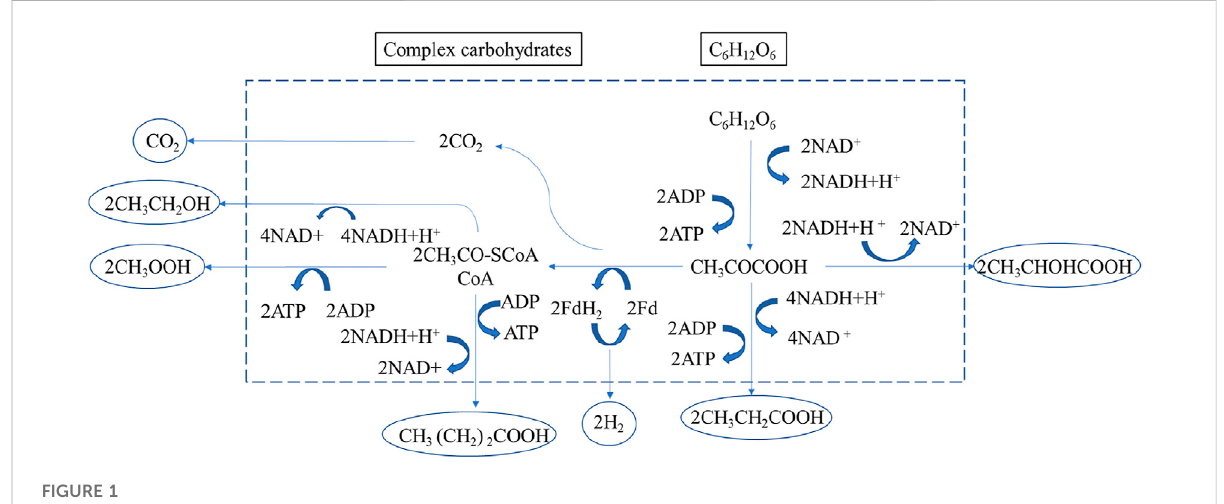
FIGURE 1 Carbohydrate fermentation pathways (Ren et al., 2007).